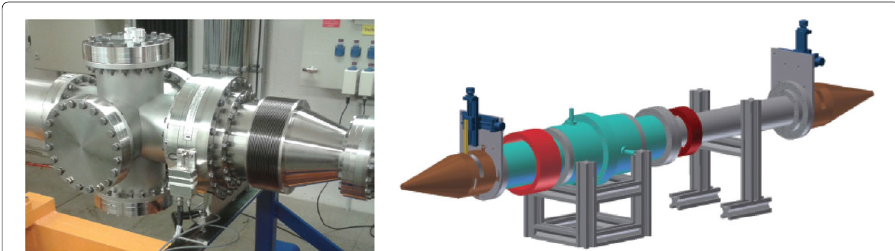
Fig. 9 Left: Fast Current Transformer from Bergoz Instrumentation installed at COSY. The FCT in the ring is equipped with a custom build preamplifier and a current source for calibration. Right: The test station for the beam current measurement devices. Different beam current sensors can be implemented into the test stand. The wire inside the tube is moved using XY tables (blue) mounted on both sides of the system. The wire tension system is covered inside the tapers (copper colored)